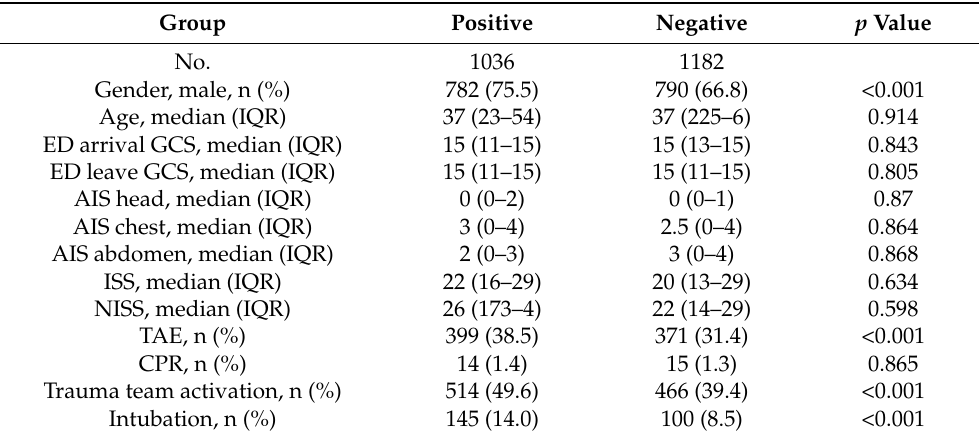
Table 1. The demographic feature comparison between each